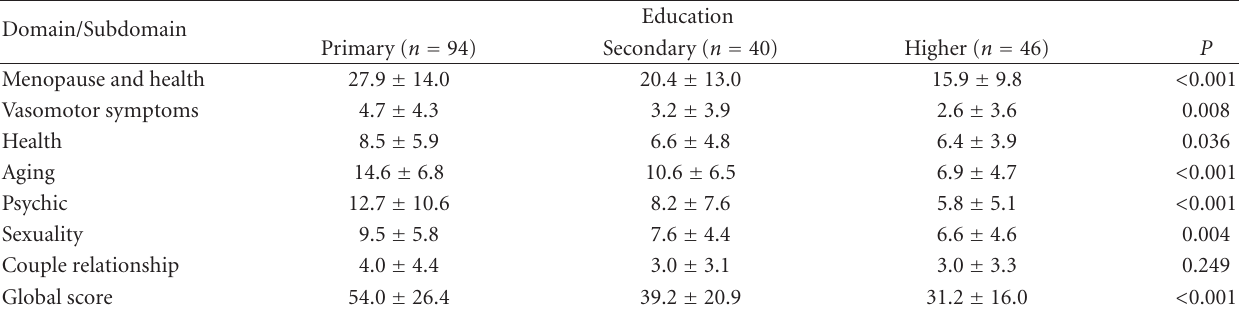
Table 4: Mean cervantes scale scores in brazilian women according to schooling.